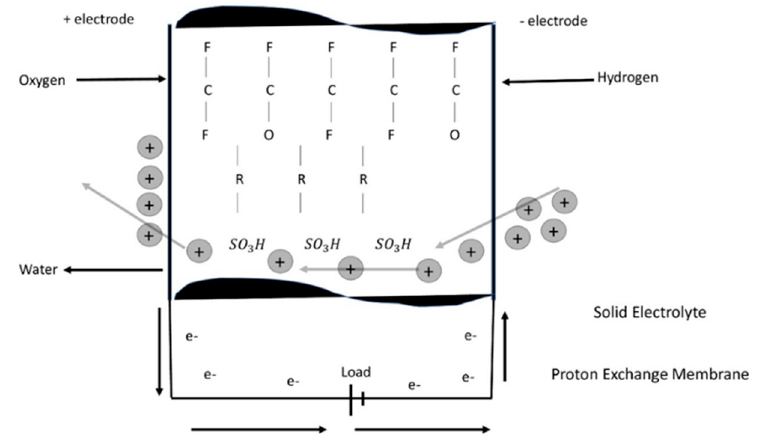
Figure 5. Cross-sectional view of the PEM fuel cell.